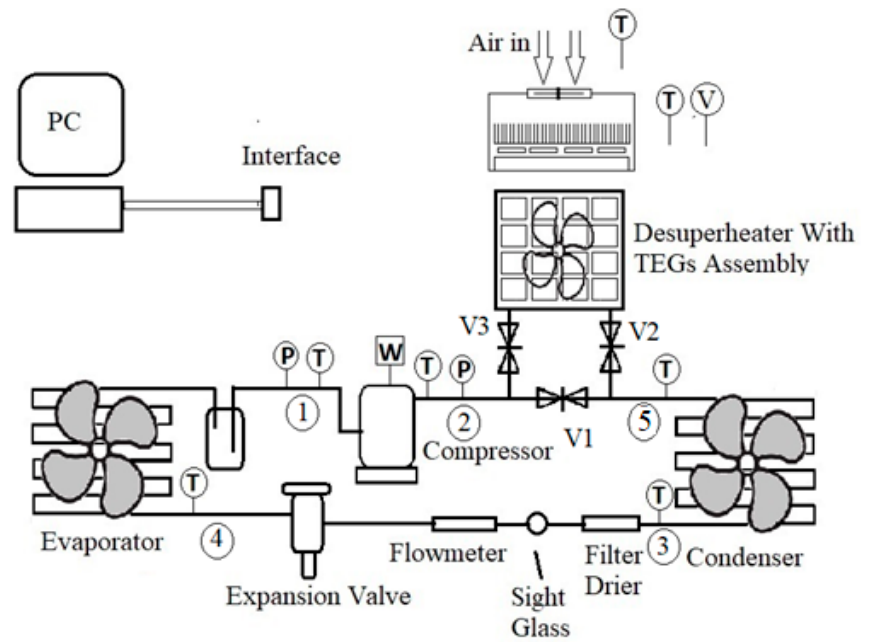
Figure 1. Schematic of refrigeration cycle and proposed integration of HE-TEGs unit for de-superheating waste heat recovery.